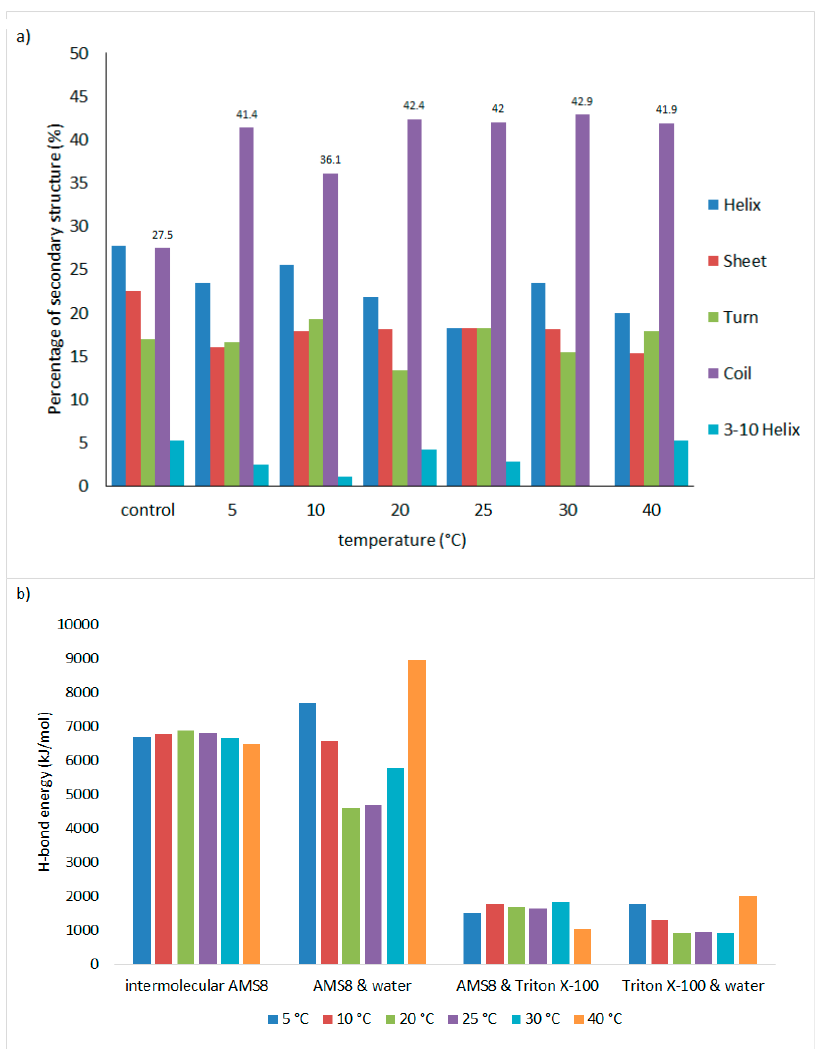
Figure 1. ( a ) Influence of temperature on the secondary conformation of the AMS8 lipase and ( b ) the total hydrogen bond energy (kJ/mol) required to stabilize the AMS8 lipase in Triton X-100/toluene reverse micelles.